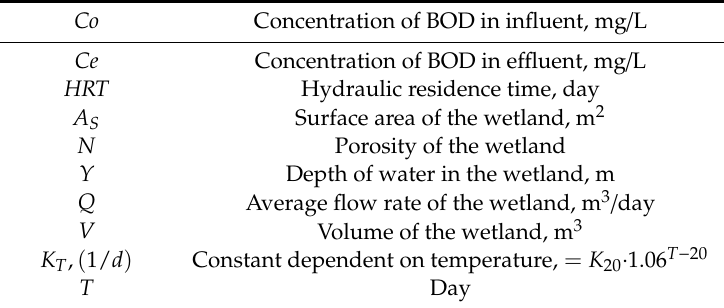
Table 1. Parameters of design. BOD—biochemical oxygen